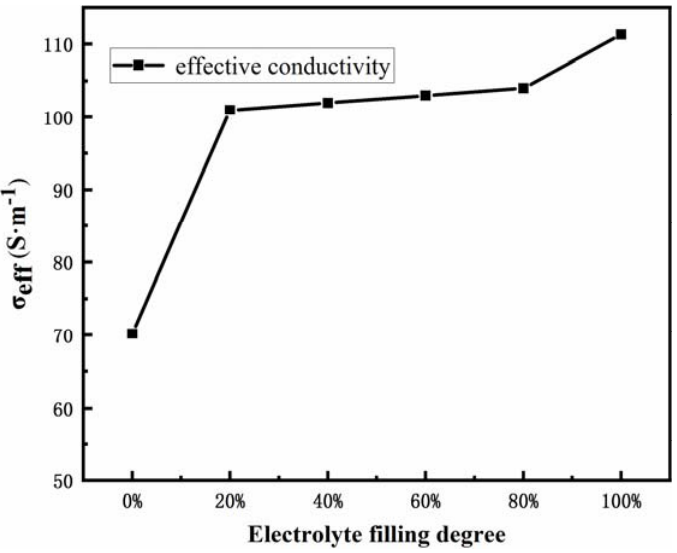
Figure 10. Effective electrical conductivity.